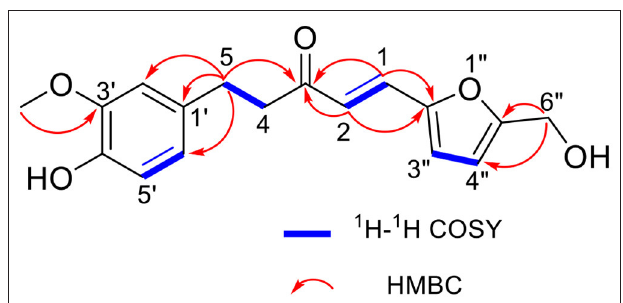
FIGURE 2 | The key 1 H- 1 H COSY and HMBC correlations of